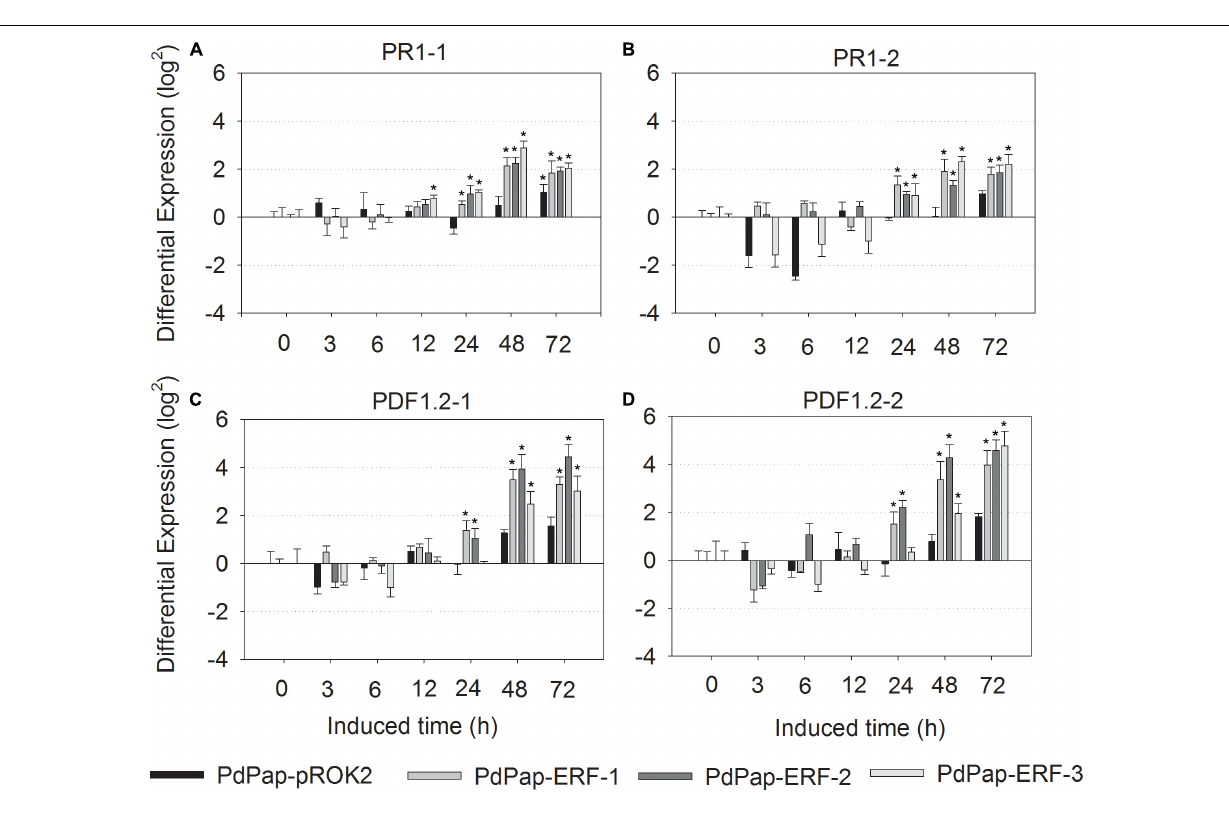
FIGURE 7 | The differential expression of PR1 and PDF1.2 in transformant PdPap-MsERF105s. Following infected by Aal, the expression levels of (A) PR1-1 , (B) PR1-2 , (C) PDF1.2-1 , and (D) PDF1.2-2 were determined by RT-qPCR. ANOVA was conducted using Duncan’s method, and p ≤ 0.05 was considered significant. RT-qPCR: quantitative real-time